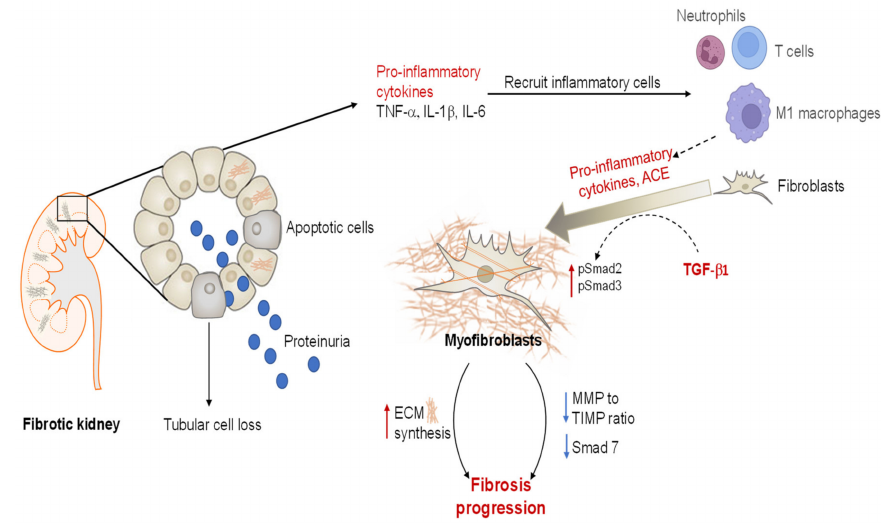
Figure 2. Fibroblast-to-myofibroblast transition during fibrogenesis, a key event in renal fibrogenesis. Following tissue injury, resident macrophages secrete cytokines such as TNF- α , IL-1 β and IL-6 to promote infiltration of more immune cells (such as macrophages and neutrophils). Macrophages also release TGF- β 1 and ACE, which convert Ang I to Ang II, both of which are pro-fibrotic factors that directly promote fibroblast-to-myofibroblast transformation, via a Smad-dependent pathway. Furthermore, the balance between the matrix-degrading MMPs and their inhibitors, TIMPs, is dysregulated, leading to impaired ECM turnover. In summary, the excessive matrix deposition observed in fibrotic kidneys results from a combination of overproduction of ECM proteins and defective ECM